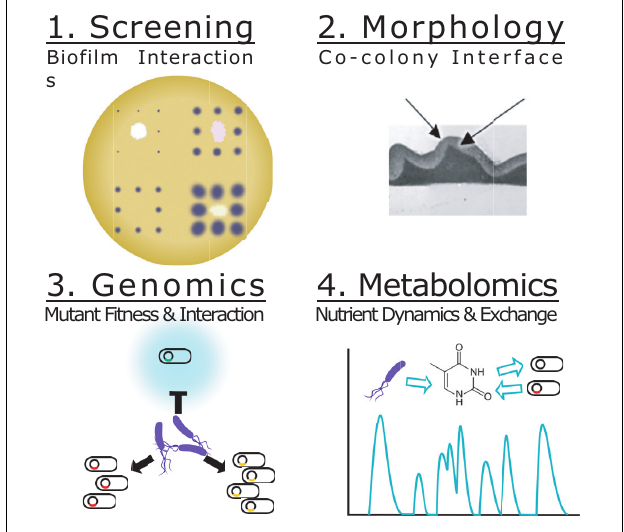
FIGURE 1 | Biofilm Interaction Mapping and Analysis (BIMA) of the biochemical and biophysical interactions required for co-colony fitness. Screening (step 1): An acoustic printer or automated liquid handling system is used to print underlay colonies of different strains spaced apart to reduce interactions and a single strain grid of overlay colonies to evaluate the macroscopic interactions of the co-colony formation including: inhibition of colonization, direct overlay growth, morphology, color and motility. Morphology (step 2): Transmission electron microscopy is used to evaluate the interface between the two co-colony strains and the changes over time. Genomics (step 3): Mutant fitness profiling of a DNA-barcoded transposon mutant library of the overlay colony allows for investigation of genes important for co-colony formation and fitness. Metabolomics (step 4): Mass spectrometry based metabolomics is used to analyze the metabolites consumed/released in the co-culture vs.